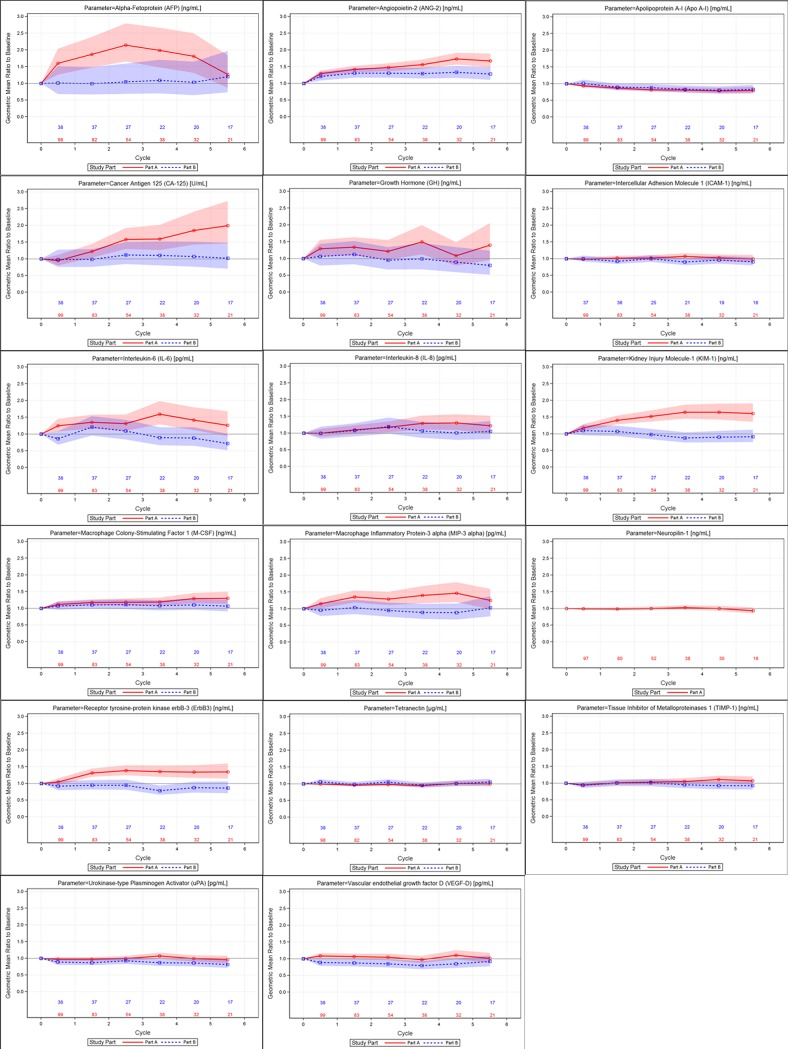
Geometric mean ratio to baseline for selected proteins from the Multianalyte Immunoassay Panel (Parts A and B). Shaded area represents the confidence band and is color-coded by study part.